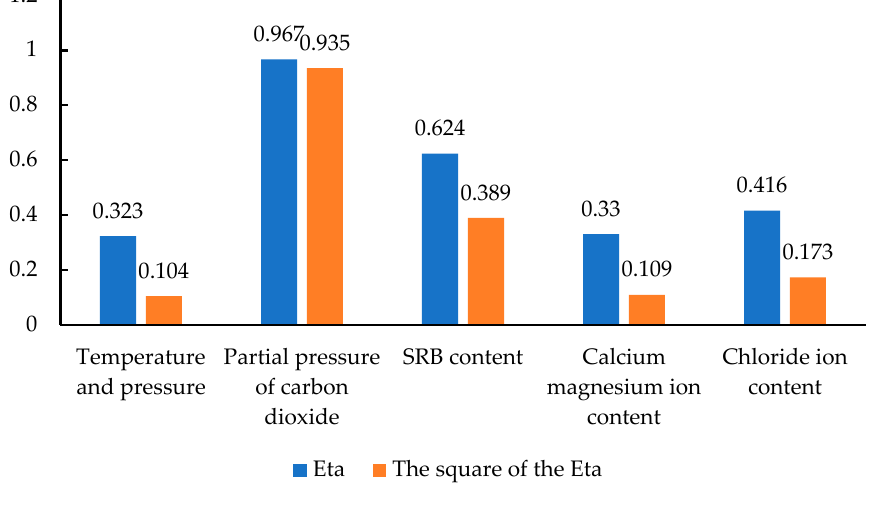
Figure 10. Microscopic corrosion morphology of hanging piece under different Cl − content. ( a ) Cl − content 40,000 mg/L; ( b ) Cl − content 45,000 mg/L; ( c ) Cl − content 49,250 mg/L; ( d ) Cl − content 55,000 mg/L; ( e ) Cl − content 60,000 mg/L.